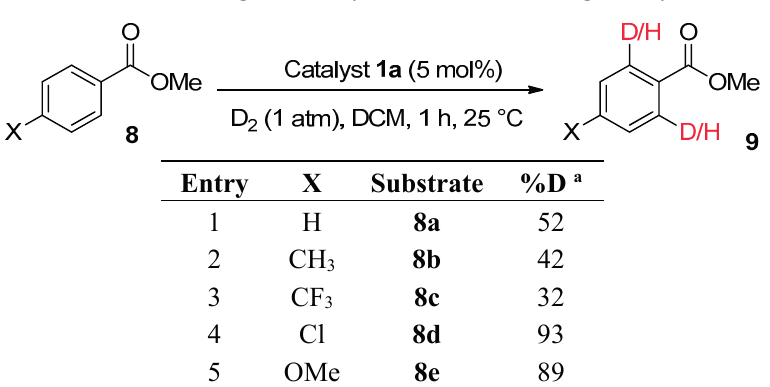
Table 1. Labelling of methyl benzoates 8 using catalyst 1a .